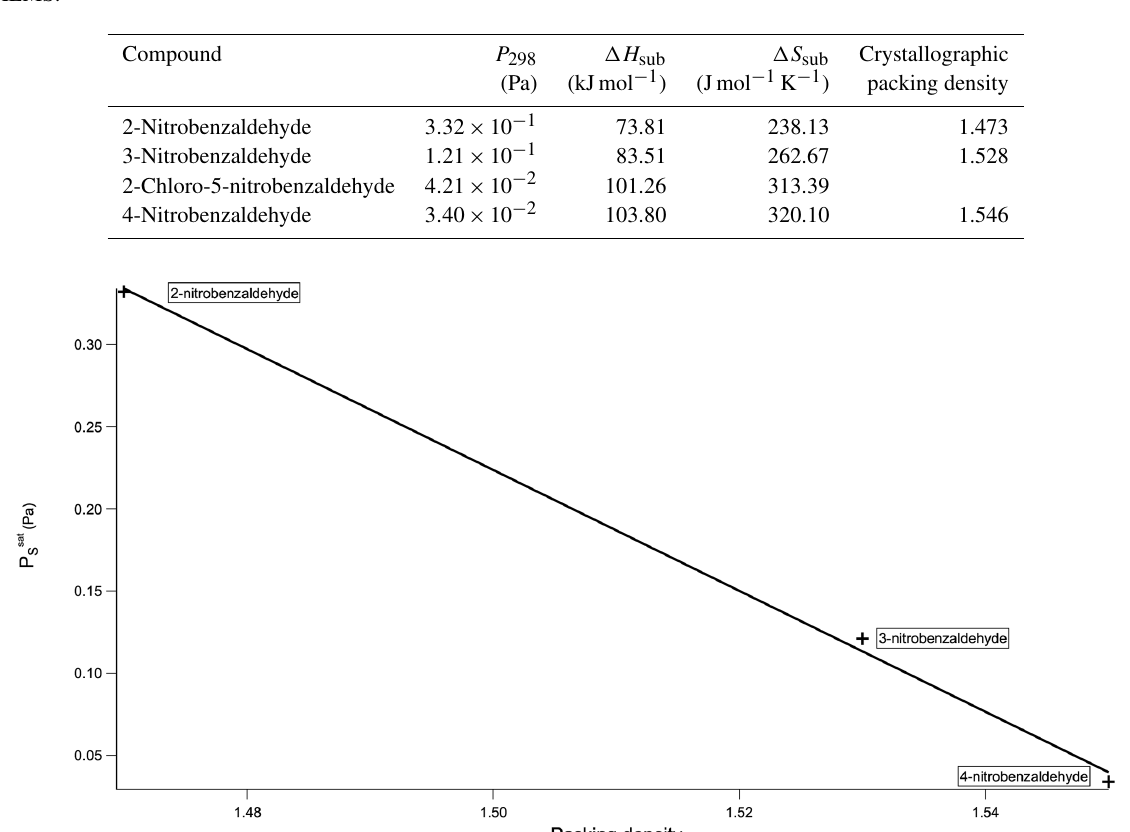
Table 5. P sat at 298K, enthalpies and entropies of sublimation, and crystallographic packing densities of nitrobenzaldehydes determined S using KEMS.